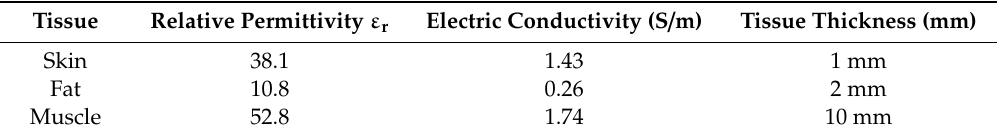
Figure 6. Geometry of the proposed P-fed I-shape MSA. ( a ) Proposed antenna after downsizing; ( b ) simulation setup on the multi-layer tissue model. Table 1. Multilayer human tissue model